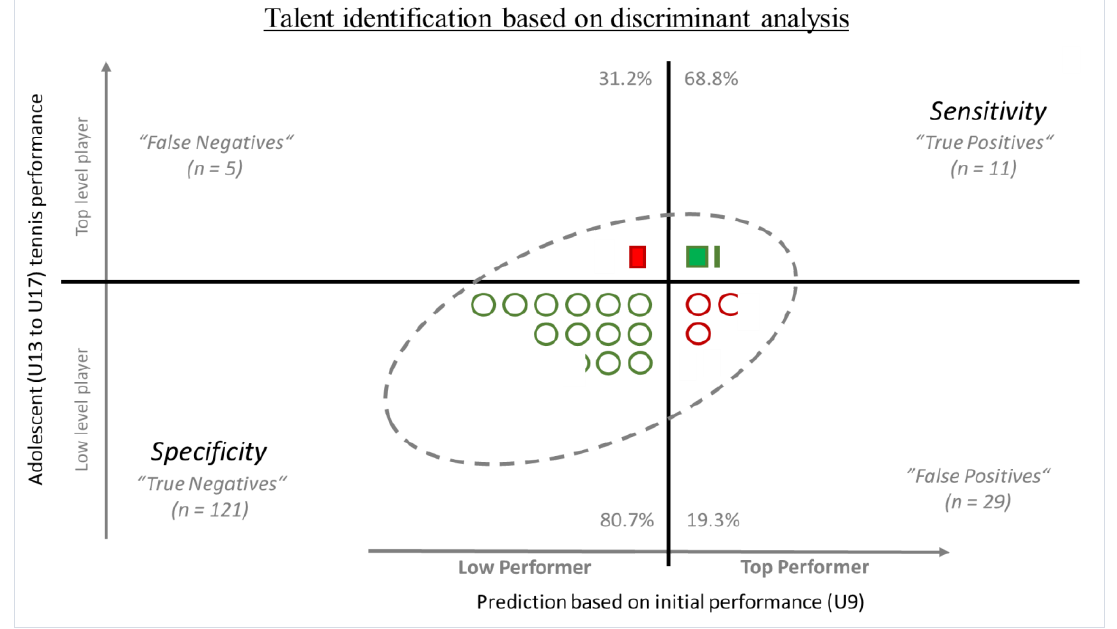
Figure 2. Discriminant analysis to predict later U13‒U17 tennis performance group based on initial performances (U9; each full symbol represents ten children).